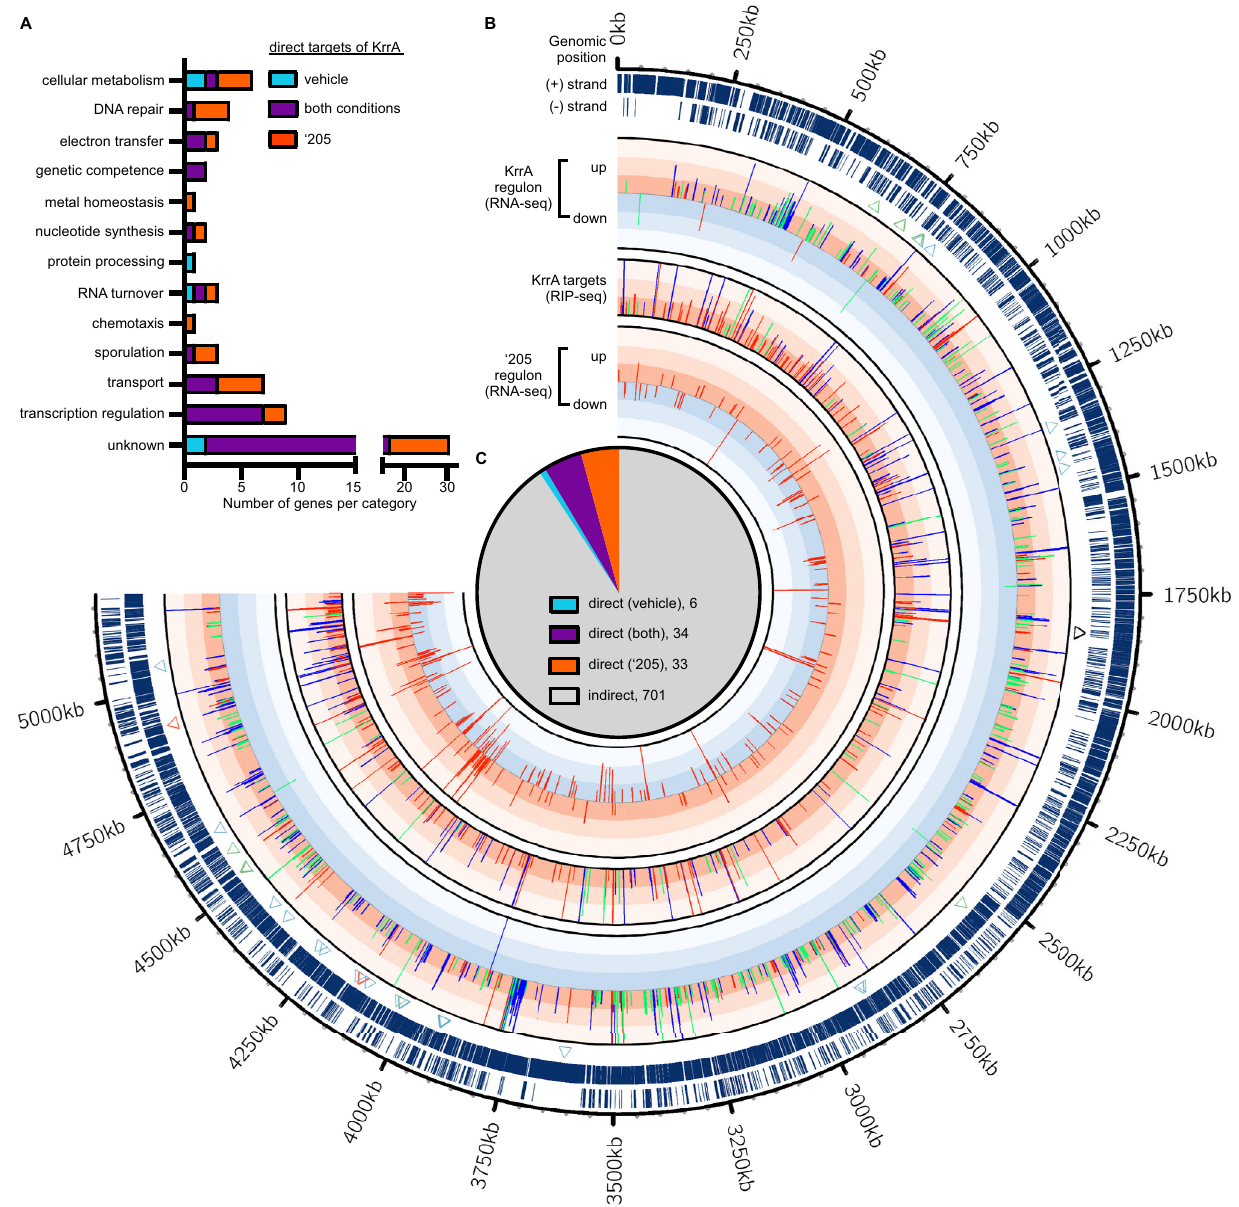
Fig. 7 Combined fRIP-seq and RNA-seq datasets uncover the broad effects in gene expression and coregulatory gene networks modulated by KrrA function. A The transcript abundance of 73 direct targets was signi fi cantly affected by KrrA regulation and these direct RNA targets are grouped into various functional categories. B Combined fRIP-seq and RNA-seq data showing global changes modulated by KrrA function. Each bar represents a gene with signi fi cantly differential abundance. Each level of color gradation represents a fi vefold change. Genes with ≥ 15-fold change are represented with bars that hit the maximum limit. The bars in different colors show genes with differential abundance under vehicle (green), ‘ 205-treated (red), or both conditions (blue). The triangles indicate the KrrA-regulated transcripts that are involved in TCS signaling (black), competence (red), sporulation (green), and germination (blue). C Overview of KrrA targets revealed by comparing the datasets of fRIP-seq and